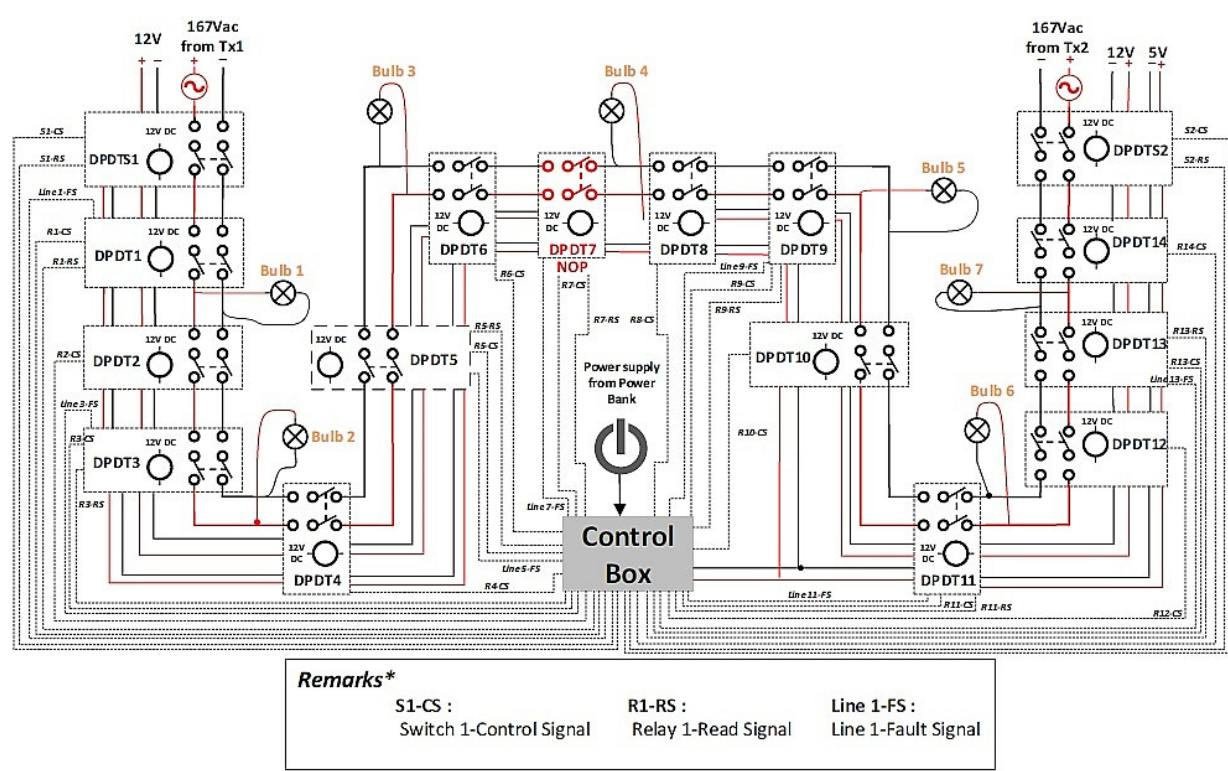
Figure 7. Schematic diagram for hardware setup.